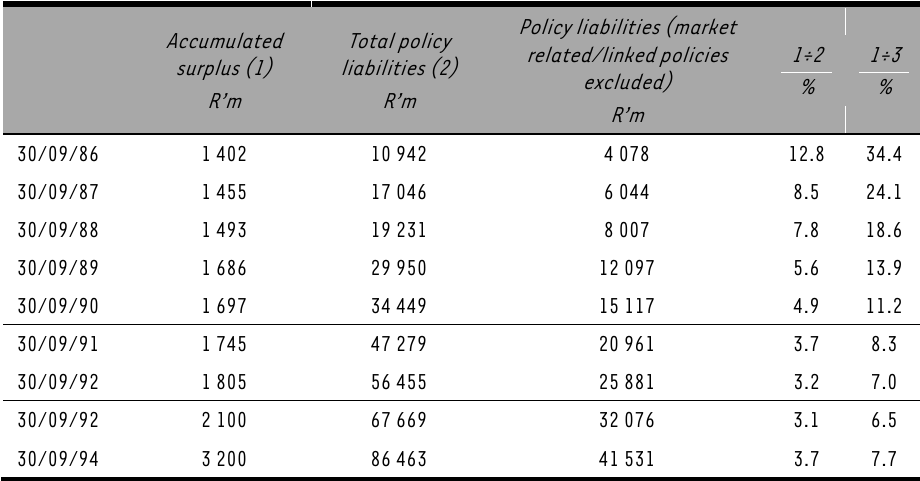
TABLE 6: Sanlam accumulated surplus and policy liabilities, 1986-1994